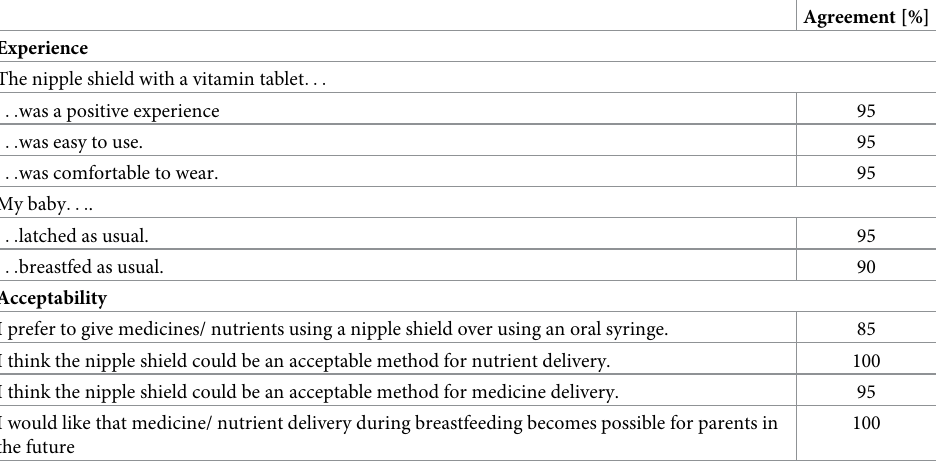
Table 4. Summary of reported maternal experience and acceptability of the study